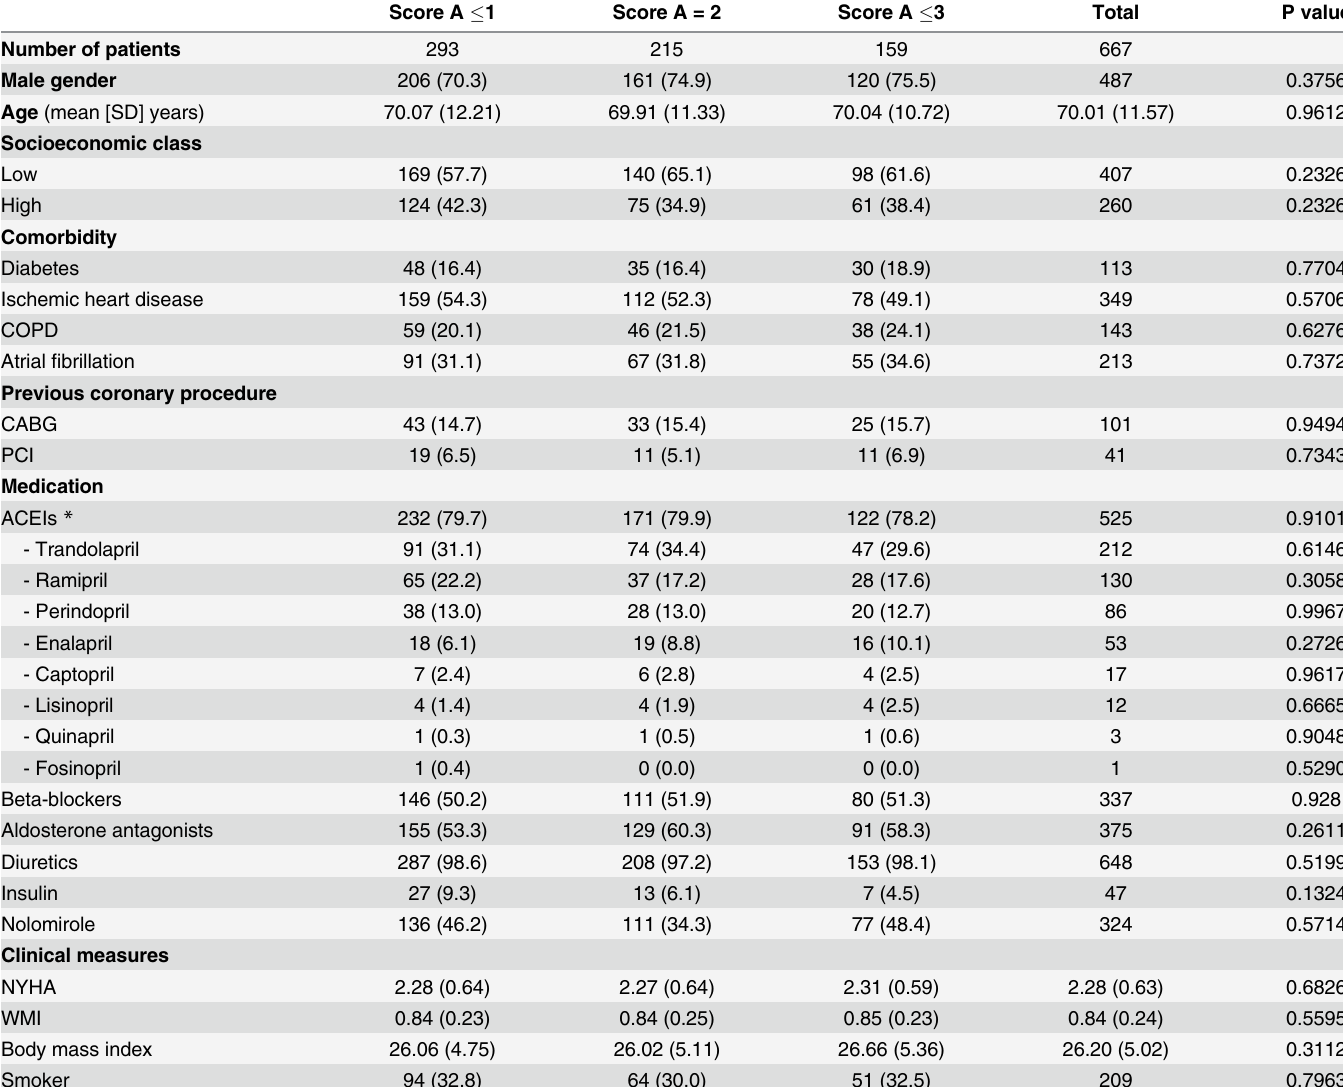
Table 1. Baseline clinical characteristics for patients with genetic score